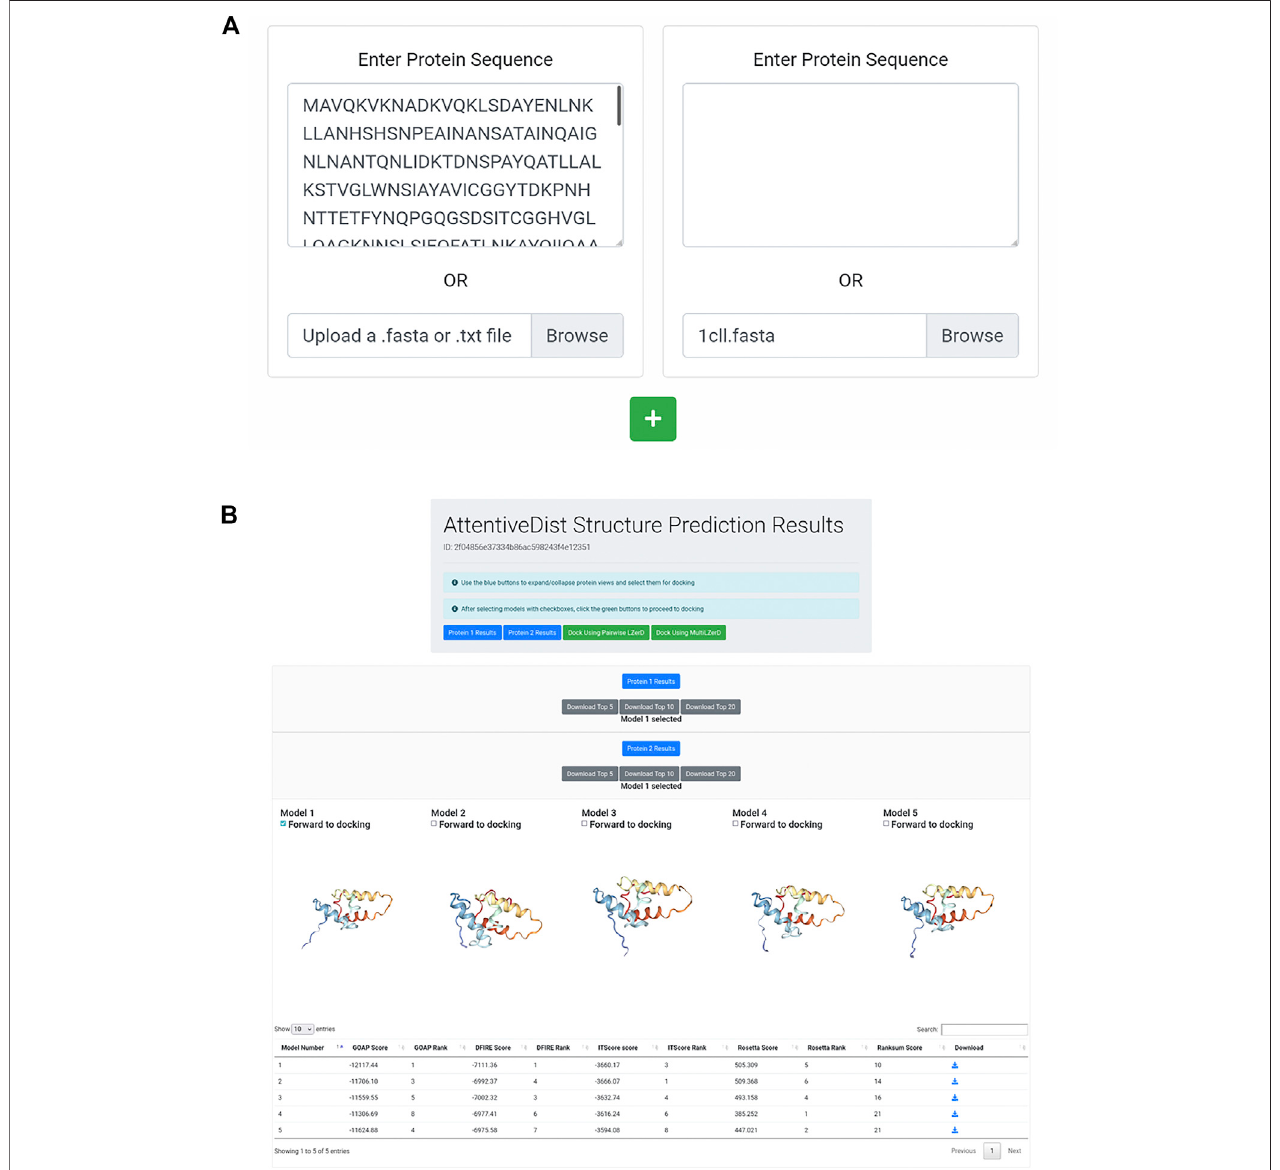
sequence, top fi ve scoring models are visualized. Scores of the fi ve models are shown in a table below the visualization panel. The models are ranked by the ranksum score.